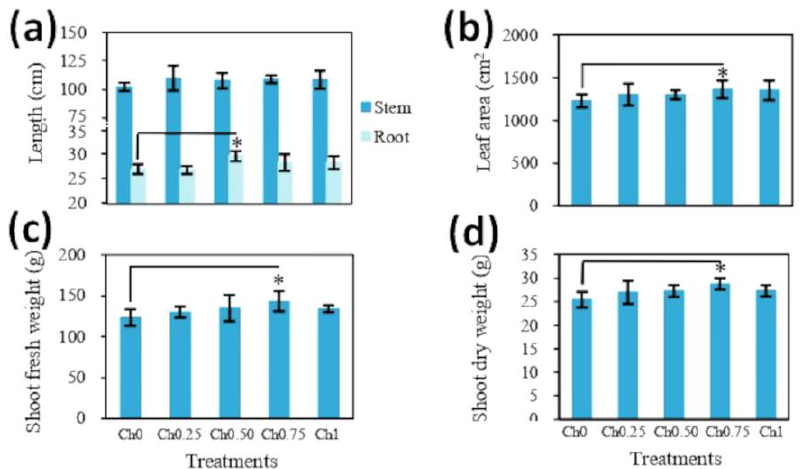
Figure 2. Effect of foliar spray with chitosan on the length of shoots and roots ( a ), leaf area ( b ), and shoot biomass ( c , d ) of tomato plants. Five treatments were applied until fruit ripening with 0 mg mL −1 (Ch0), 0.25 mg mL −1 (Ch0.25), 0.50 mg mL −1 (Ch0.50), 0.75 mg mL −1 (Ch0.75), and 1 mg mL −1 (Ch1) chitosan, and four-month-old plants were analyzed. The results were expressed as the mean of 6 independent replicates ± SD. * indicates significant differences between treatments following one- way ANOVA (Duncan’s multiple range, p ≤ 0.05).